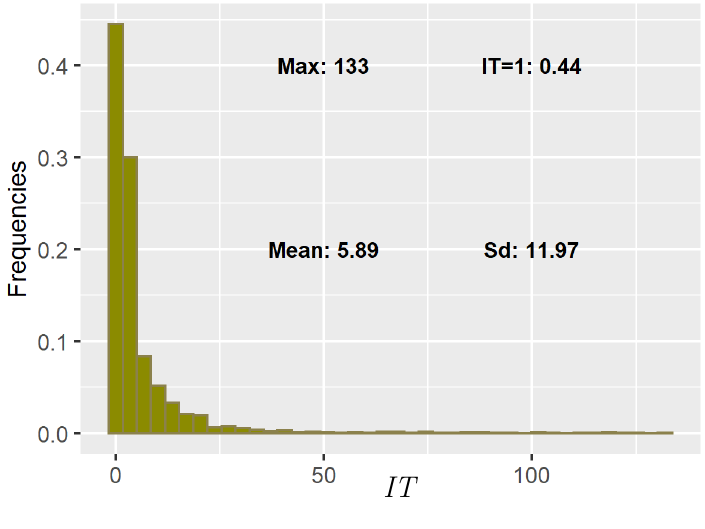
Figure 1. Histogram of the empirical IT frequency for the Trapani station over the whole year. The range is up to 133. The mode is IT = 1 with relative frequency 0.44. The mean and the standard deviation are 5.89 and 11.97